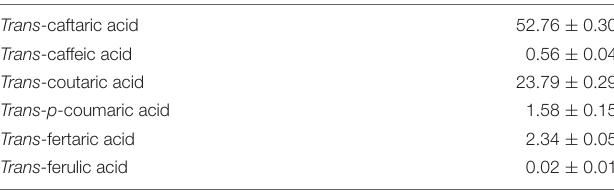
TABLE 1 | Concentrations in mg/L of HCAs and their tartrate esters in a mix of 30% pasteurized red wine and 70% MRS broth. Trans -caftaric acid Trans -caffeic acid Trans -coutaric acid Trans-p- coumaric acid Trans -fertaric acid Trans- ferulic